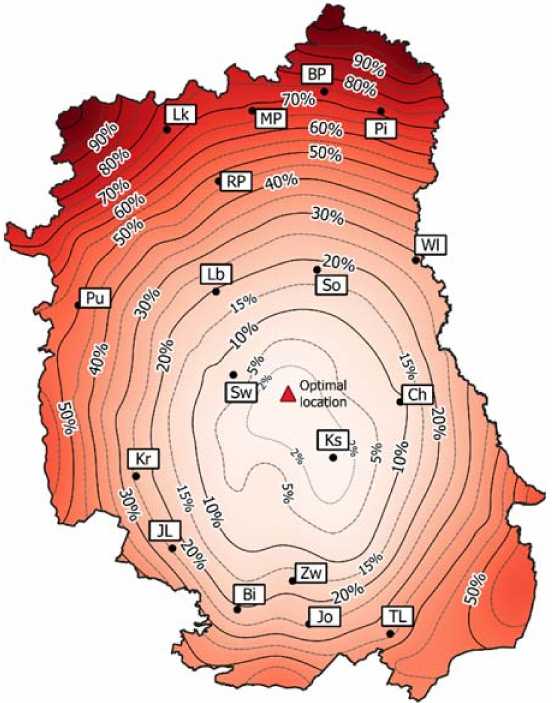
Figure 7. Map with contours for relative cost increase in comparison with the optimal one. During the next stage, the road network was simplified. The exact topography and the actual shape of roads is not needed for graph algorithms; it was approximated with the use of straight lines. The graph constructed in this way is presented in Figure 3. The vertices of the graph show the current locations of the pellet production points (vertices filled with black color) and the points of intersection of main roads in the Lubelskie Voivodeship as approximate locations of a potential pellet storage point (filled with white color). In total, the graph contains 122